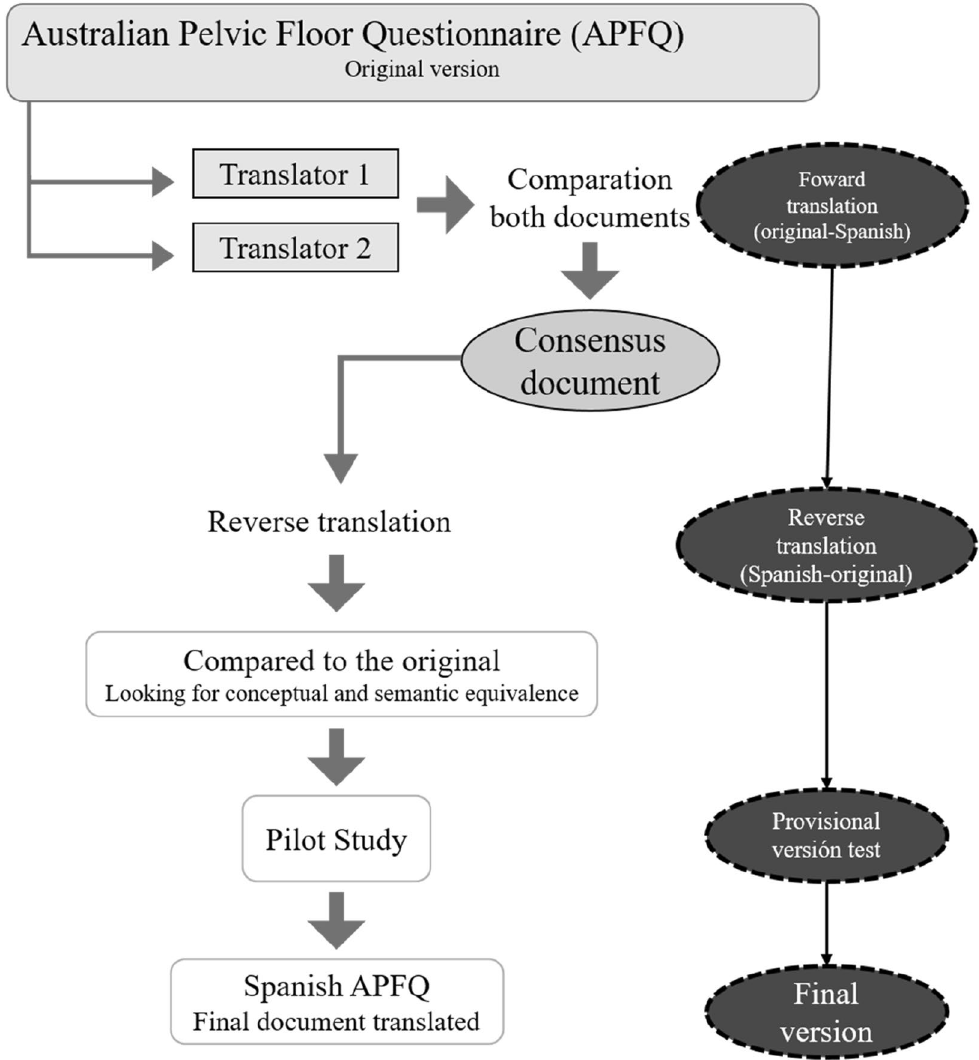
Figure 1. Flowchart of the development process APFQ Spanish